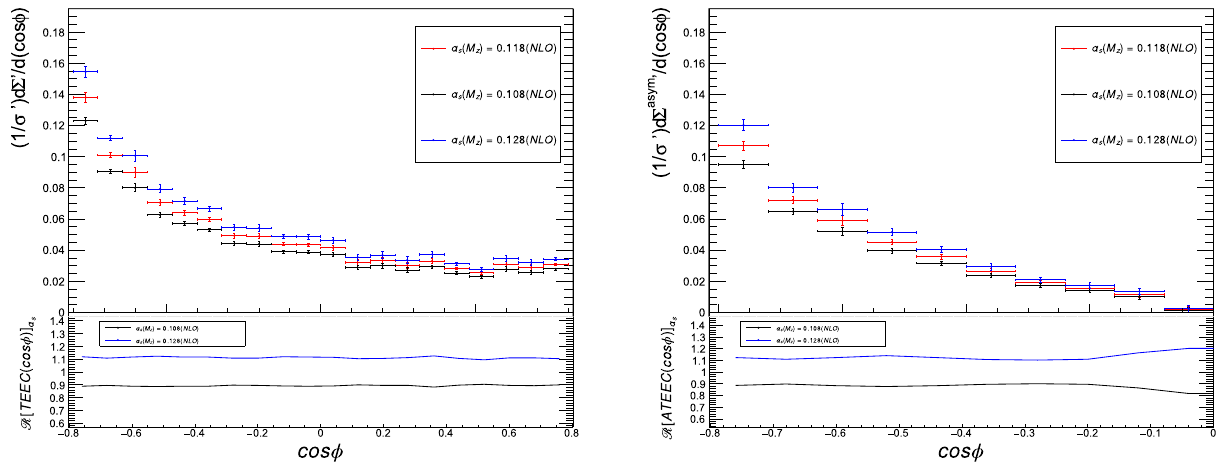
) = 0 . 108 , 0 . 118 , 0 . 128 using the PDFs Z